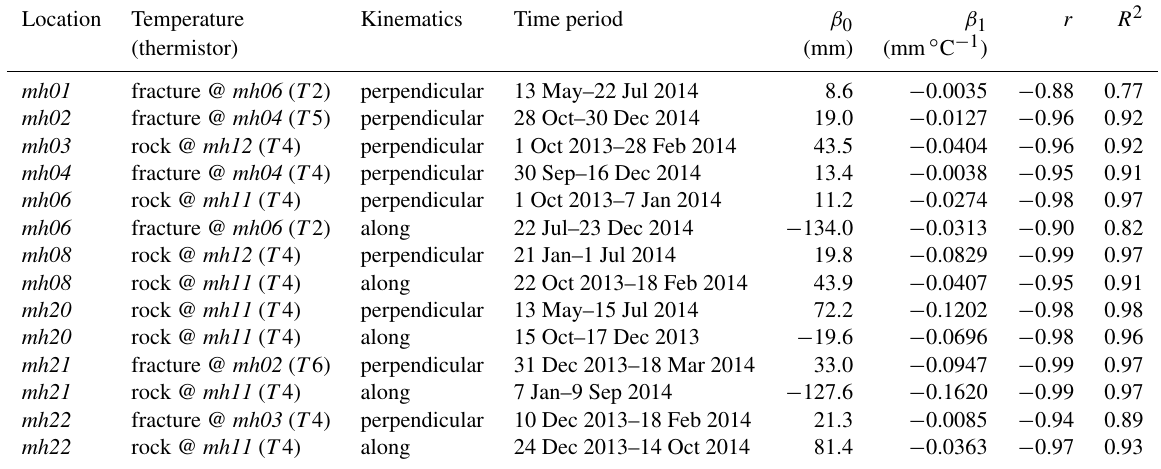
Table 2. Regression analysis between temperature (rock or fracture) and observed fracture displacements (perpendicular and along fracture). Regression parameters intercept β 0 and slope β 1 , correlation coefficient r and coefficient of determination R 2 for the time period with the highest correlation coefficient are listed. Depth of the most representative temperature (thermistor T ) is described in Table 1.